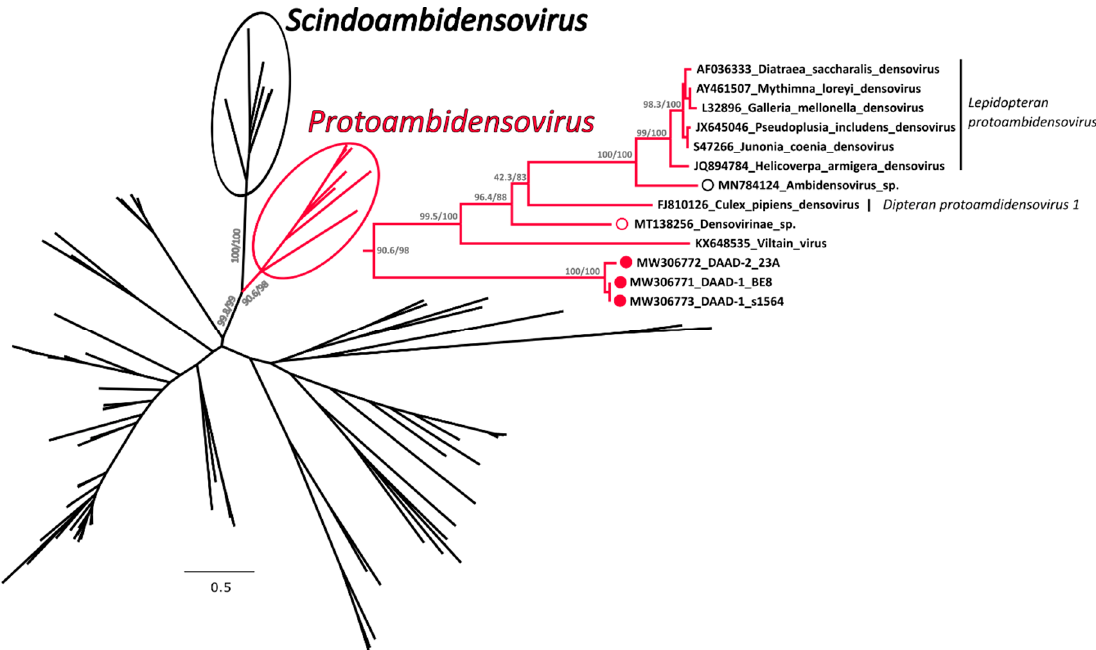
Figure 4. Phylogenetic analysis of the duck associated ambidensovirus (DAAD) within the Densovirinae . The phylogenetic tree based on 117 full NS1 protein sequences was built with the maximum-likelihood method based on the General matrix (LG) + F + R6 model with IQ-Tree [31]. The outcomes of the SH-aLRT and bootstrap test are shown for main nodes. The branches of the unrooted tree are color-coded based on the taxonomy and red represents putative members of the genus Protoambidensovirus (enclosed in a red circle and shown in extenso on the right), while black includes all other viruses. The black circle indicates viruses within the genus Scindoambidensovirus . The viruses identified in this study are labelled with a full red circle, while viruses found by others in vertebrates are indicated by an empty red and black circle for avian and mammal studies, respectively. Species designations, when available, are indicated on the right.